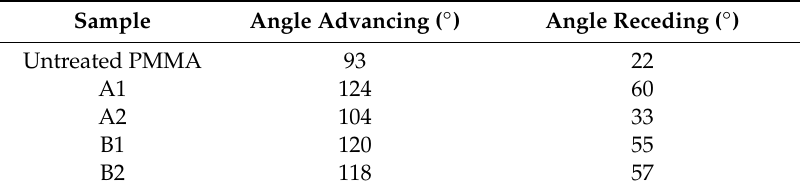
Table 4. Contact angle of the samples used for immersion